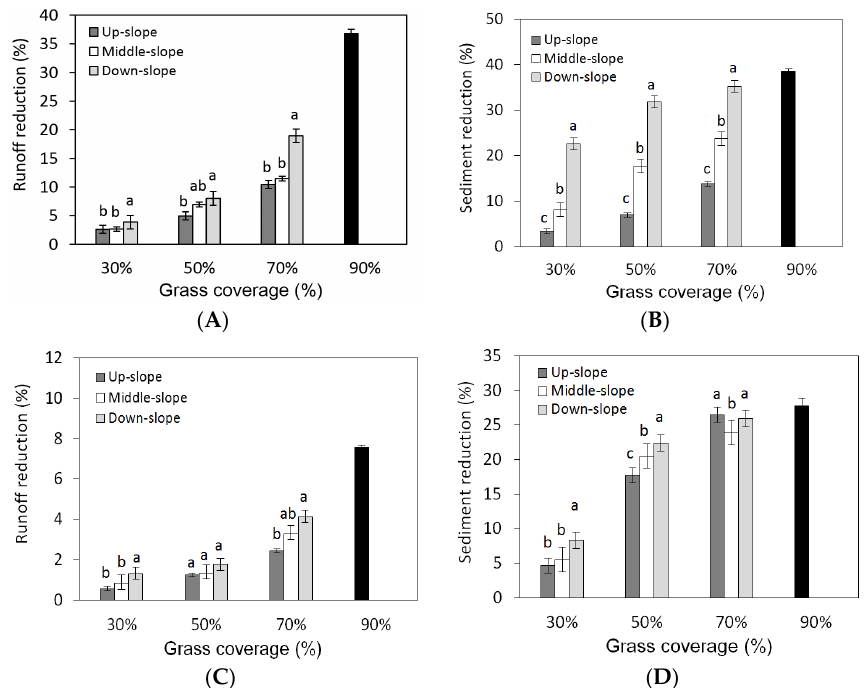
Figure 3. Runoff and sediment reduction of the slope-gully system under the different grass coverage, different grass spatial arrangement patterns, and different flow discharges (Mean values of the same letter in different columns are not significantly different at p = 0.05 level using the least significant difference method). ( A ) (Q = 3.2 L · min − 1 ). ( B ) (Q = 3.2 L · min − 1 ). ( C ) (Q = 5.2 L · min − 1 ). ( D ) (Q = 5.2 L · min − 1